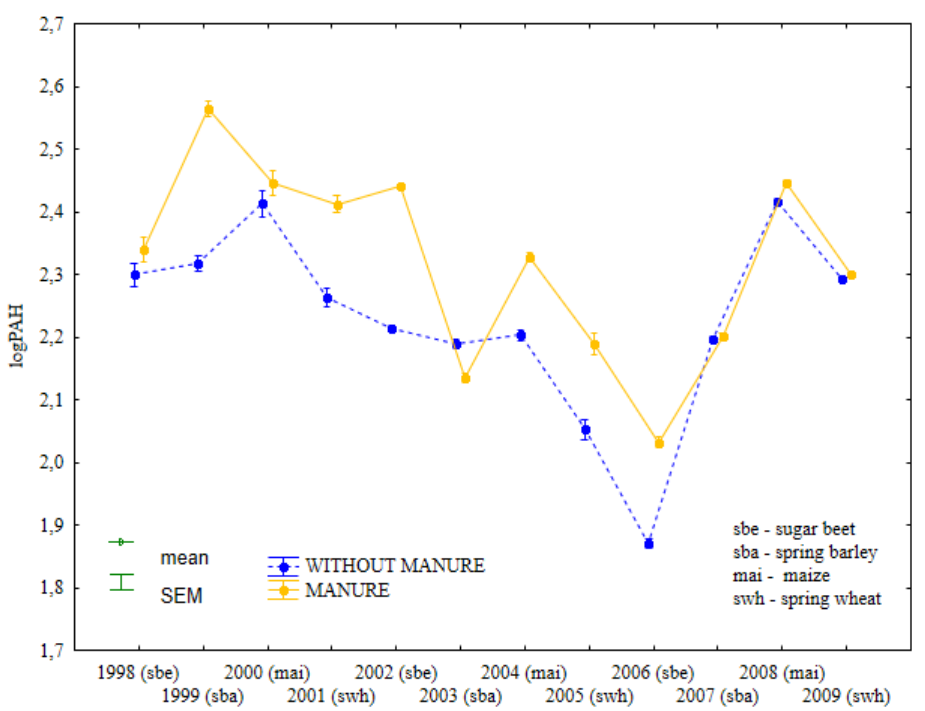
Figure 6. Total content of 16 PAHs in soil under different crops in treatments supplied with both manure and mineral fertilizers or mineral fertilizers only (log transformed data for 1998–2009).